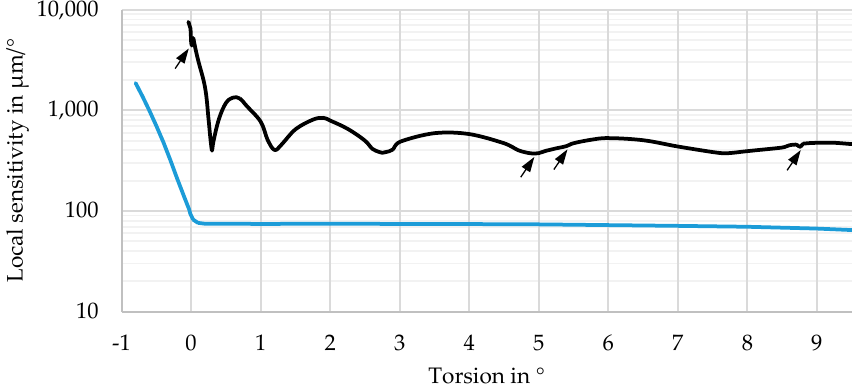
Figure 9. Local sensitivity for torsion. Black: lateral offset 𝑒 = 1 mm , blue: 𝑒 = 0 mm . Table 2. Number of reflections 𝑛 (cid:2928) , local sensitivity 𝜎 and gain factor 𝜎 𝜎(cid:3548)⁄ at 𝜑 = 0 for different numbers of faces 𝑛 and coupling angles 𝜀 , decentral coupling ( 𝑒 = 1 mm ).